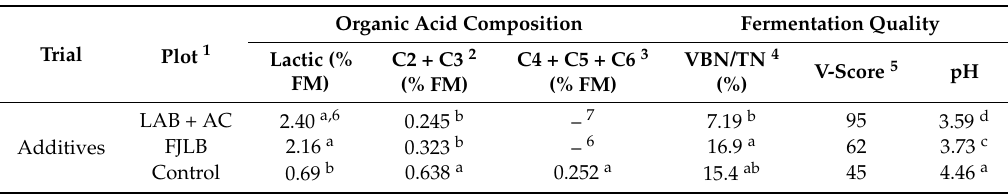
summer season (Experiment